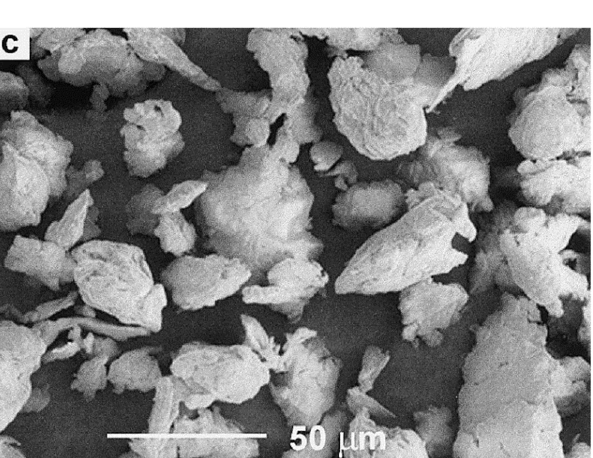
Figure 4. PET particles milled at ambient temperatures for 16 h, Reprinted with permission from ref. [204], Copyright 2021 Elsevier.